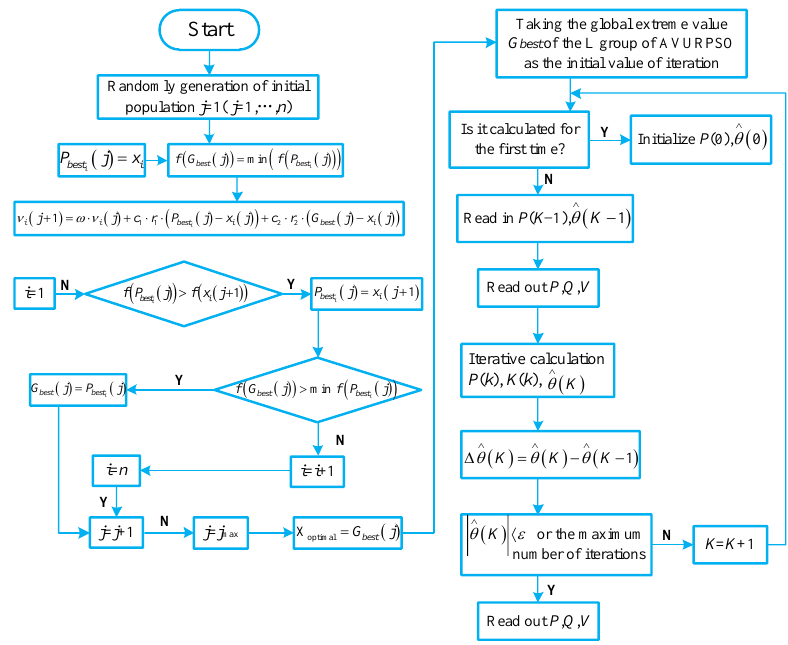
Figure 4. The flow chart of the IPSO-RLS optimization method. The step-by-step procedure of the proposed algorithm is explained